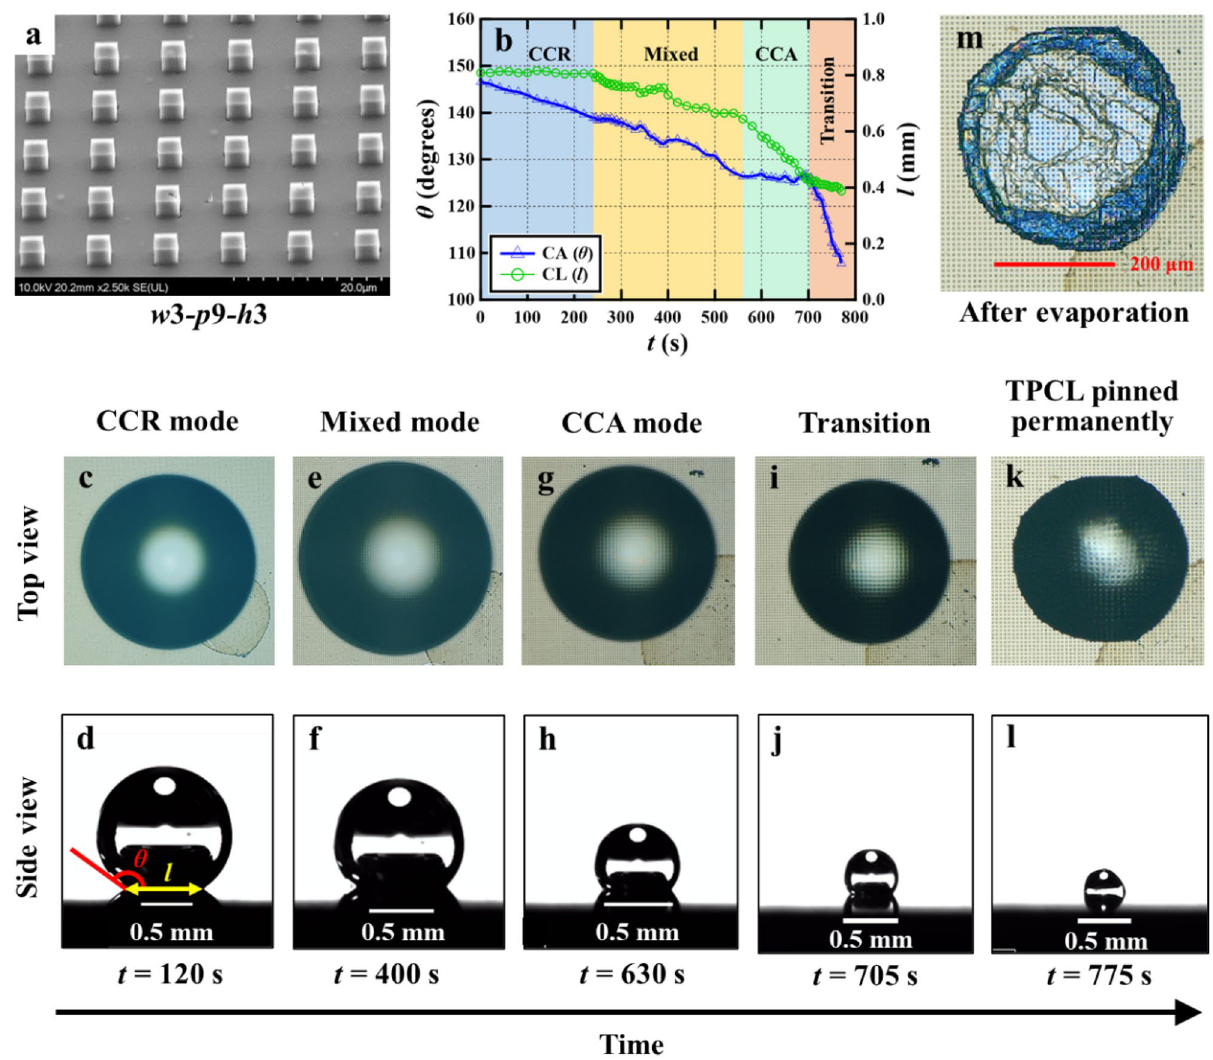
Figure 5. Illustration of the wetting transition process on surface w 3- p 9- h